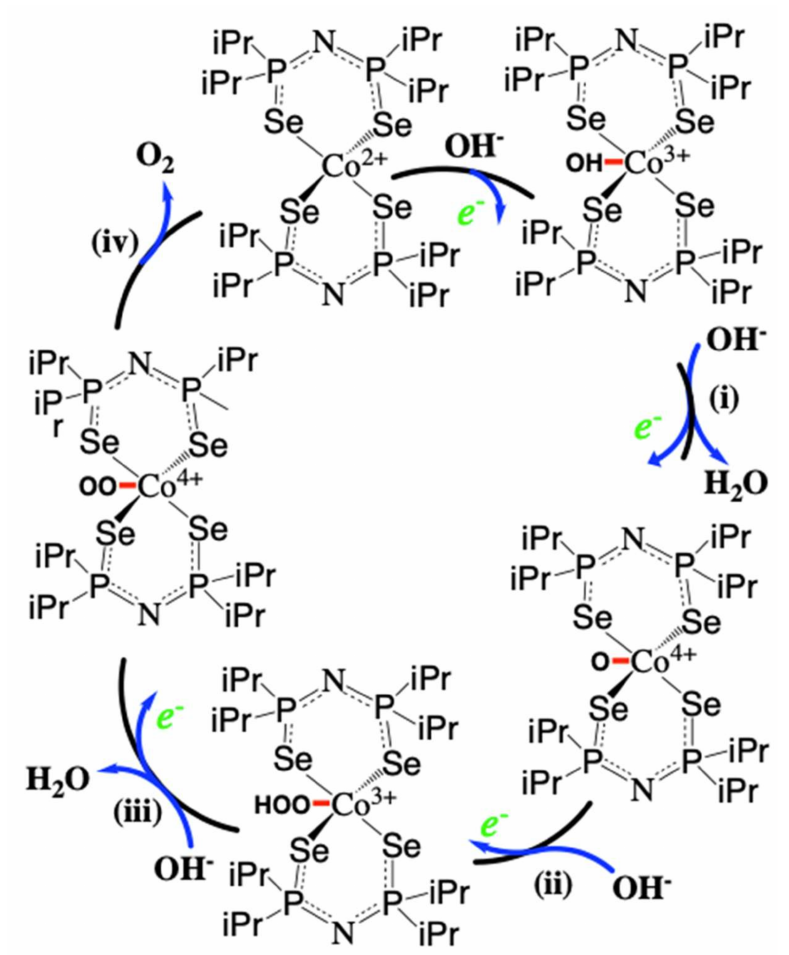
Figure 6. Schematic illustration of the proposed OER mechanism on the CoSe 4 complex through a vacant metal coordination site for OER showing the formation of a five-coordinated square pyra- midal transition state following the catalyst’s activation through -OH − coordination to Co(II) and subsequent steps of